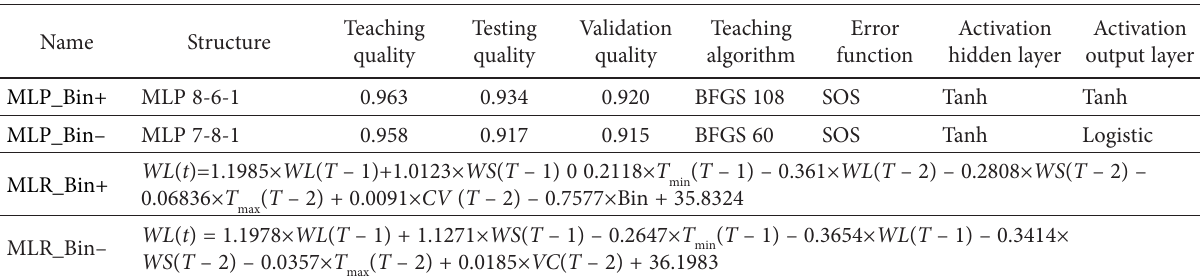
Table 4. Structure, parameters and equations for MLP and MLR models. SOS stands for sum of squared error, BFGS – is a teaching algorithm and its name is an abbreviation from its developers, namely